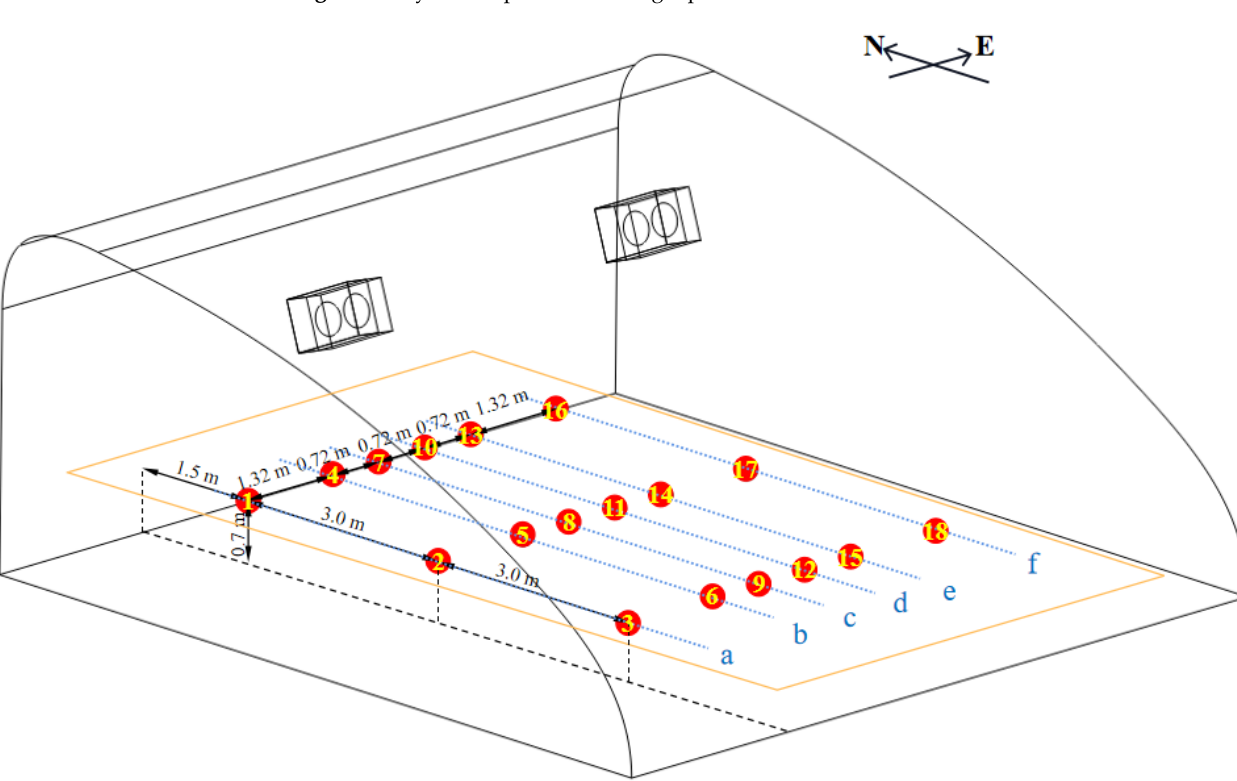
Figure 7. Layout of data collection points in the optimization target plane.